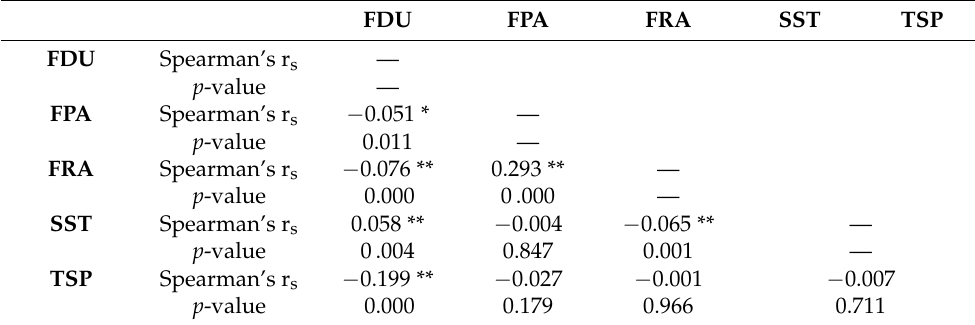
Table 2. Spearman correlation